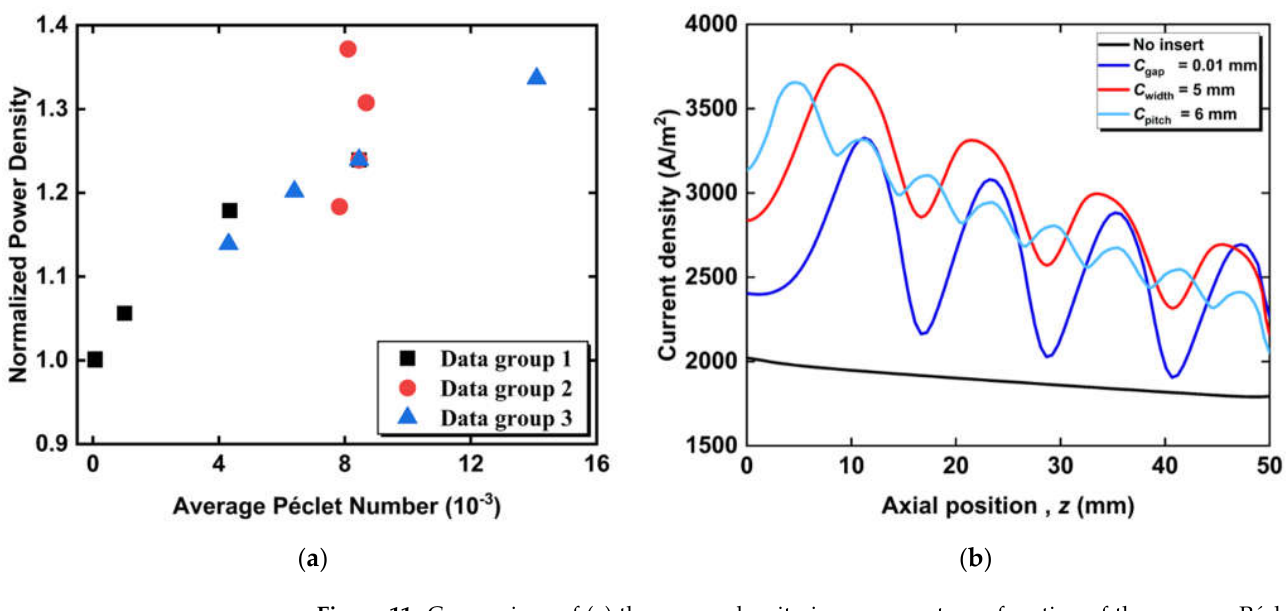
Figure 11. Comparison of ( a ) the power density increasement as a function of the average Péclet numbers for all the cases examined in Section 3.1. Data group 1, 2, and 3 respectively denotes the cases with gap, width, and pitch variations. ( b ) axial current density distributions for the micro-tubular SOFCs with and without cone-inserts.